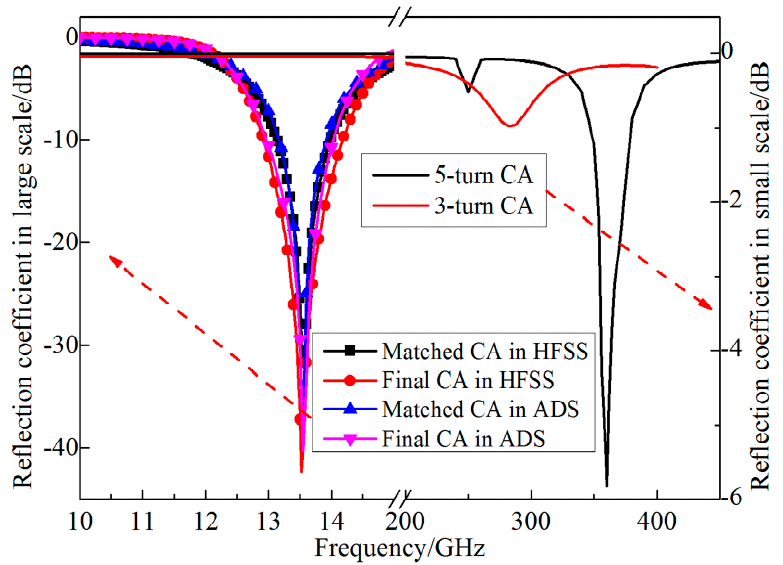
Figure 13. Reflection coefficients of all above − discussed CAs.